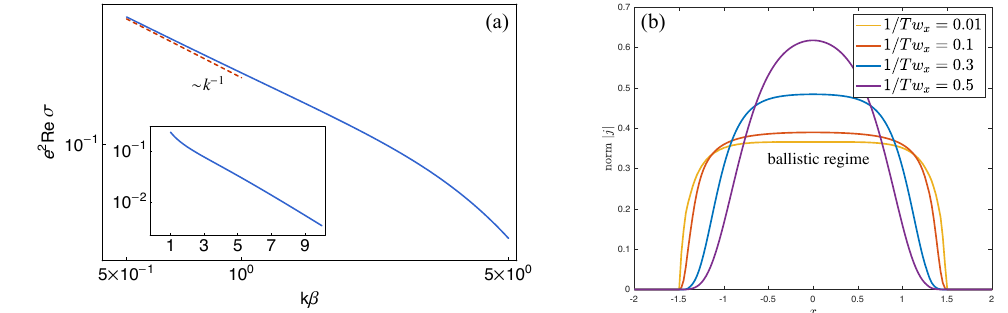
Figure 11: Conductivity and current profiles for free Dirac fermions. (a): the con- ductivity scales ∼ 1 / k at k β (cid:28) 1 while decays exponentially at k β (cid:29) 1 as shown in the inset. (b): the predicted current profile evolves from a flat to a singly peaked distribution upon decreasing the